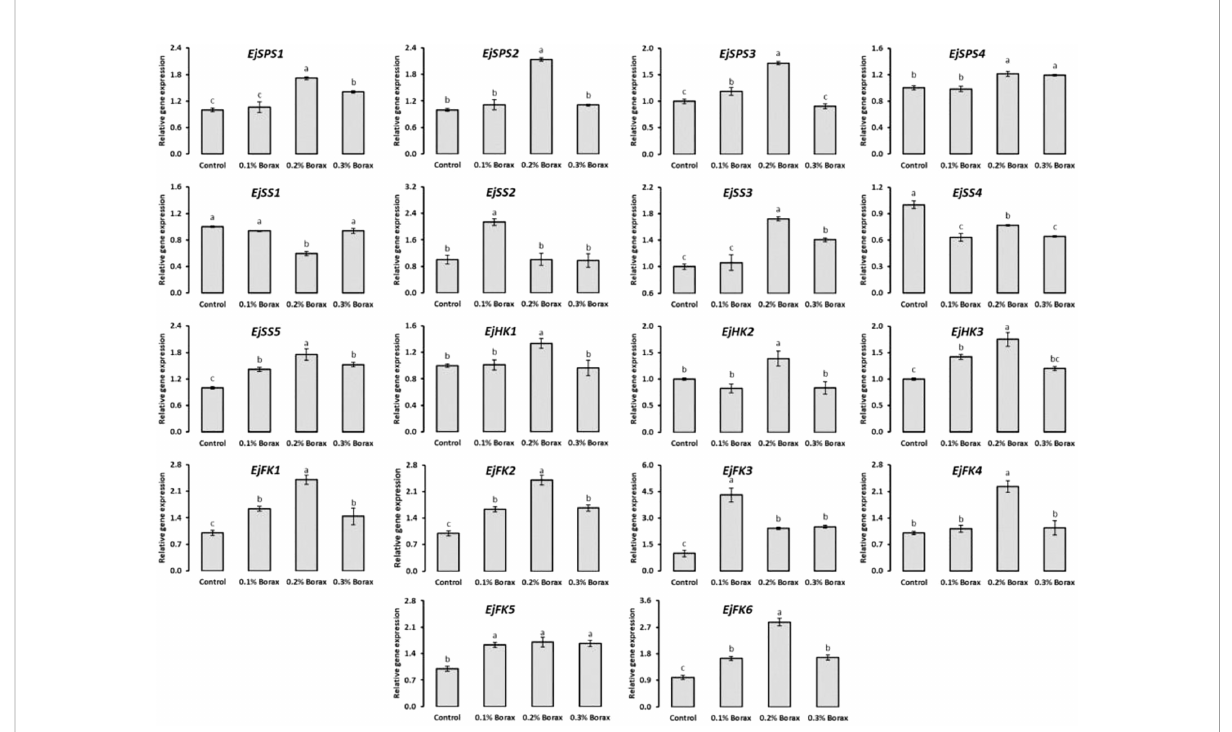
FIGURE 7 The expression pro fi ling of core genes involved in soluble sugars metabolism of loquat as in fl uenced by the foliar application of B Same letters indicate non-signi fi cant difference among treatments according to Fisher ’ s least signi fi cant difference (LSD) test, when p ≤ 0.05 . Vertical bars indicate mean ± standard error (4 biological and 3 technical